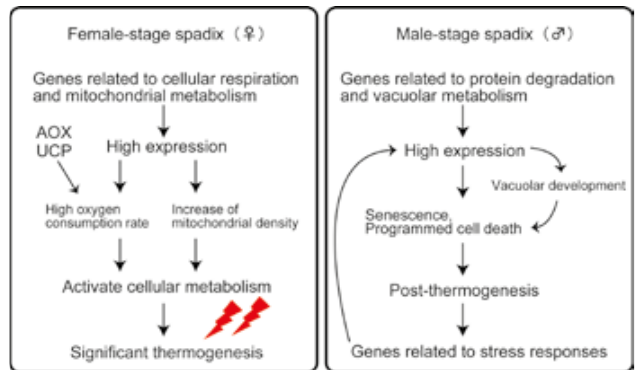
Fig. 4 - A proposed model of the possible processes in female- and male-stage spadices to maintain and terminate thermogenesis,